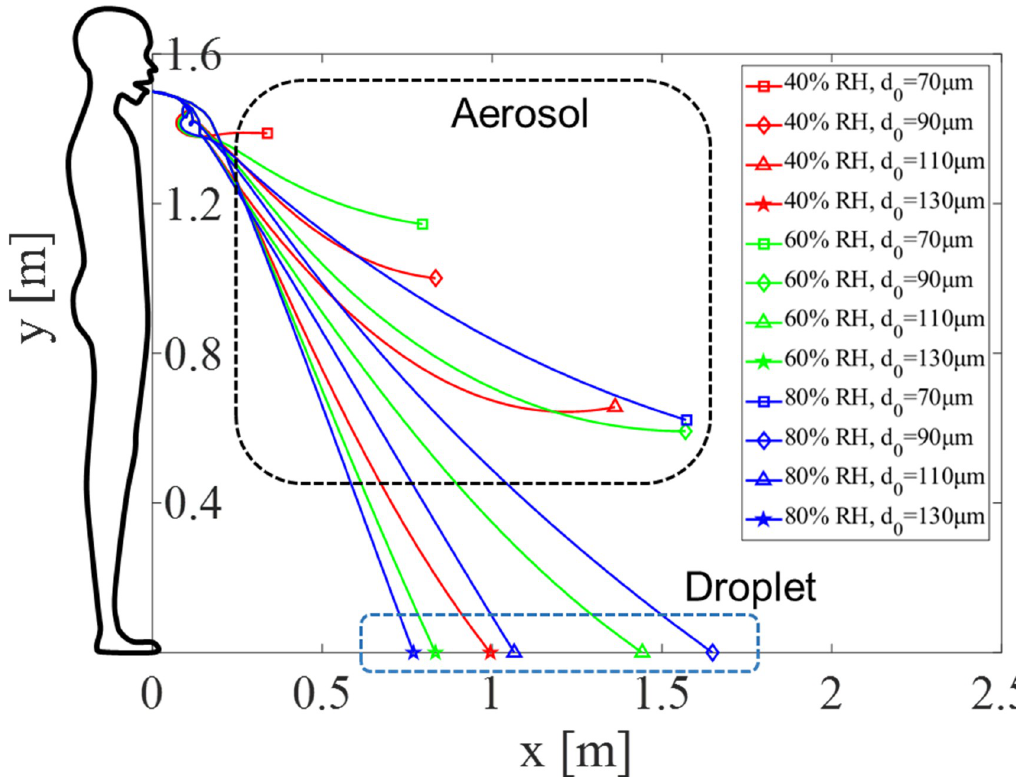
Fig 5. Droplet trajectories according to ambient relative humidity and initial droplet size at a fixed room temperature of 20˚C.